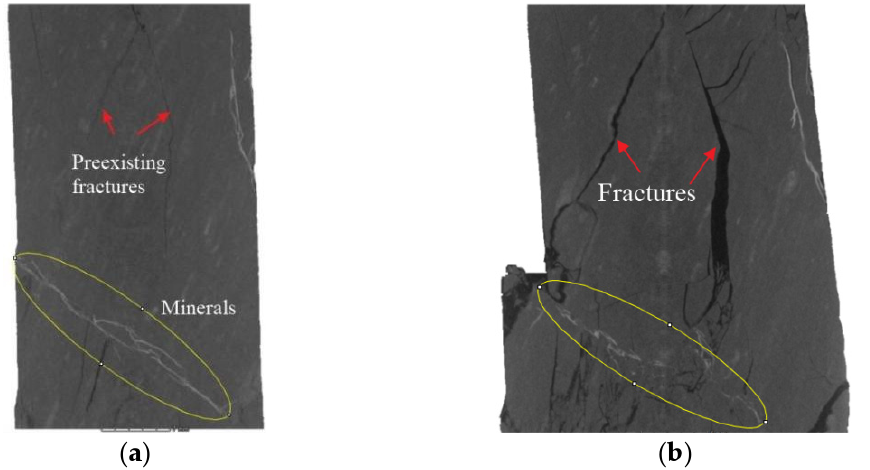
Figure 4. Vertical CT slice at the initial ( a ) and post-peak (stage 8) stages ( b ). Figure 5 shows the stress–strain curve of Sihe sample 1 at the loading stages corre- sponding to CT scans and the red numbers correspond to the stages of CT scans.